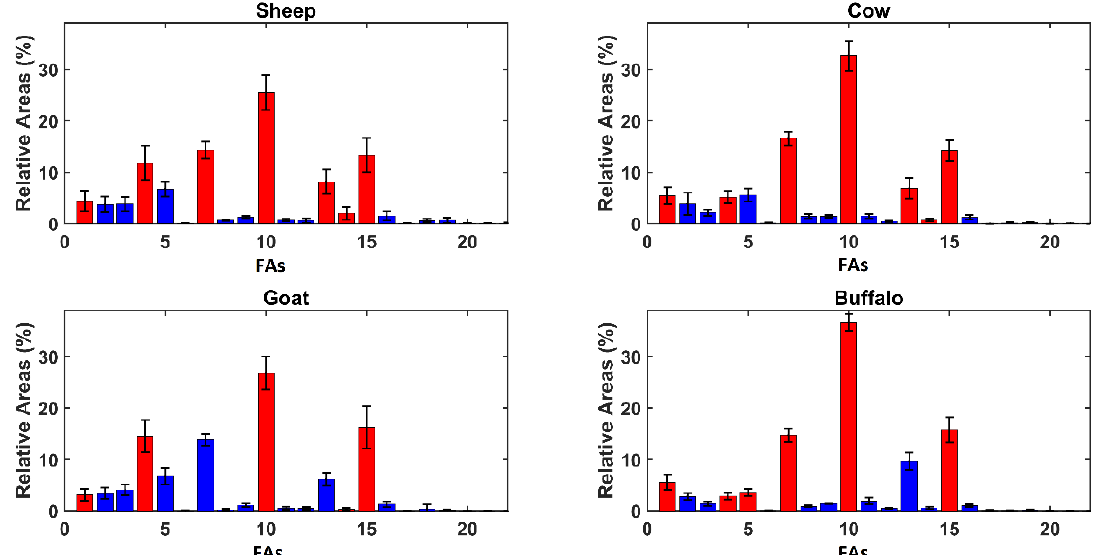
Figure 2. Average Relative Areas per genus. Red bars represent variables presenting a VIP index